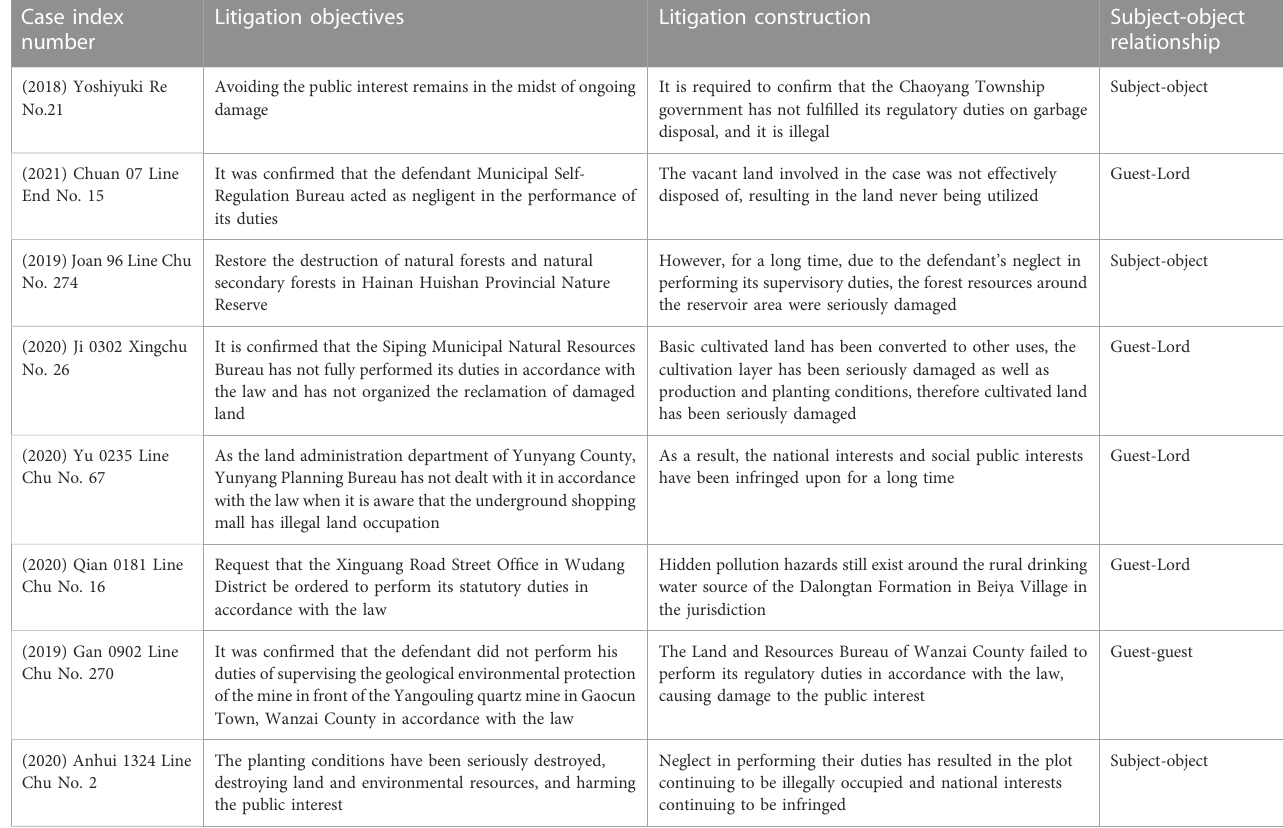
TABLE 4 Subjective and objective mutual exclusion in administrative public interest litigation for cultivated land